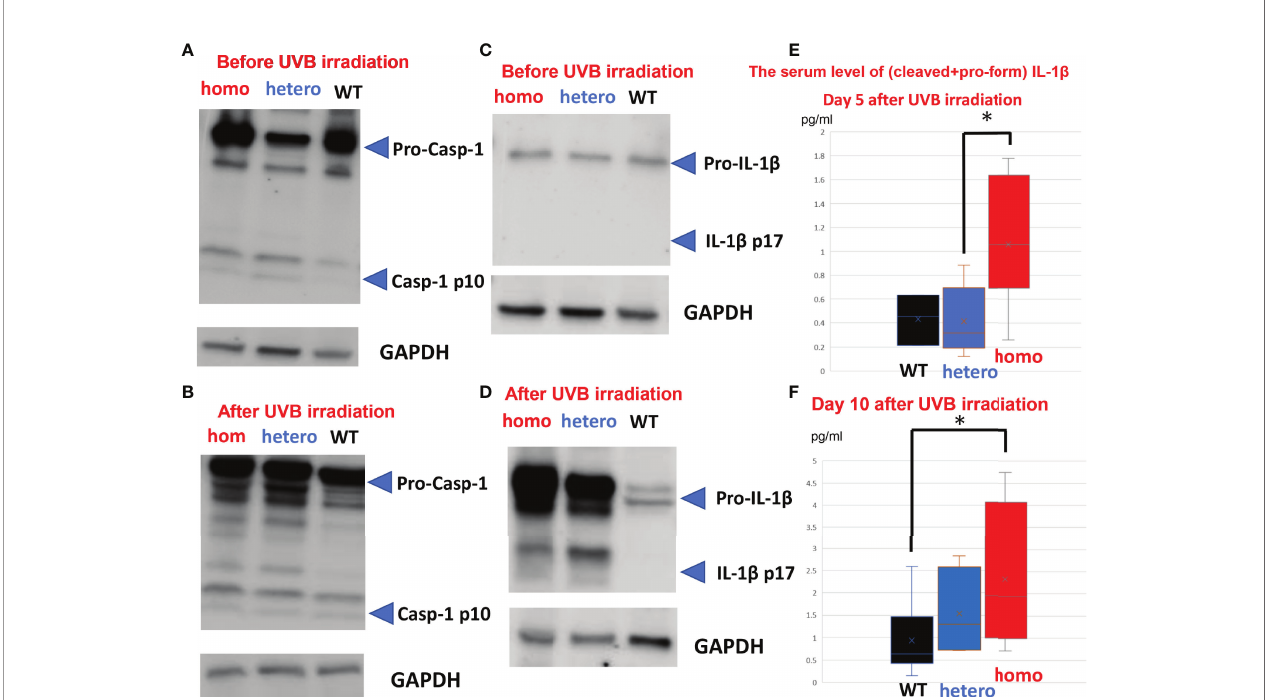
FIGURE 3 | Activation of Casp-1 and conversion from pro-IL-1 b to IL-1 b in Nlrp1b KI mice. (A) In the Nlrp1b KI (homo) mice and the Nlrp1b KI (hetero) mice, Casp- 1 p10 (cleaved form) was detected before UVB irradiation, but was not detected in the WT mice. (n = 2) (B) In the Nlrp1b KI (homo) mice, the Nlrp1b KI (hetero) mice, and the WT mice, Casp-1 p10 was detected after UVB irradiation. (n = 2) (C) In the Nlrp1b KI (homo) mice, the Nlrp1b KI (hetero) mice, and the WT mice, activated IL-1 b was not detected before UVB irradiation. (n = 2) (D) Conversion from pro-IL-1 b to activated IL-1 b was detected in the Nlrp1b KI (homo) mice and the Nlrp1b KI (hetero) mice, but not in the WT mice. (n = 2) (E, F) The serum level of IL-1 b (the total amount of cleaved and pro-form IL-1 b ) was signi fi cantly higher in the Nlrp1b KI mice than in the WT mice at Day 5 (E) and at Day 10 (F) after UVB irradiation. (n = 3-6) The serum level of IL-1 b (the total amount of cleaved and pro-form IL-1 b ) was more greatly increased in the Nlrp1b KI (homo and hetero) mice than in the WT mice at Day 10 compared to Day 5 (E, F) (n = 3-6). Signi fi cant differences are shown as *P <